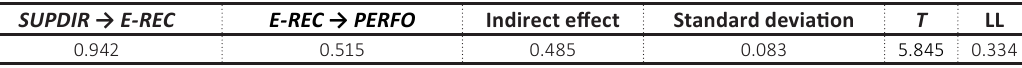
Table B5. Lower leverage and upper